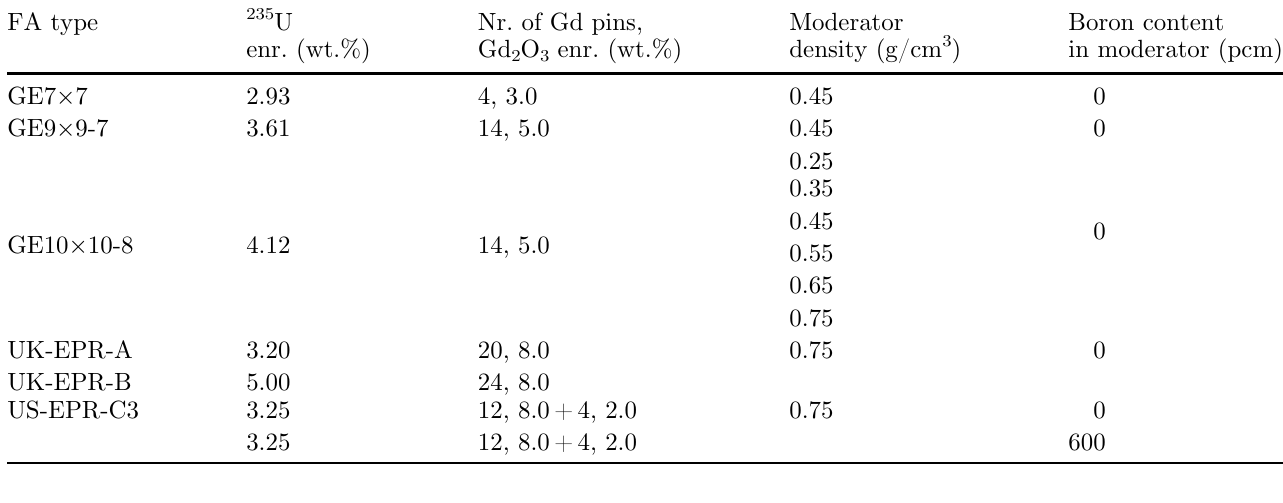
Table 4. Technical speci fi cations of PWR and BWR fuel assemblies.